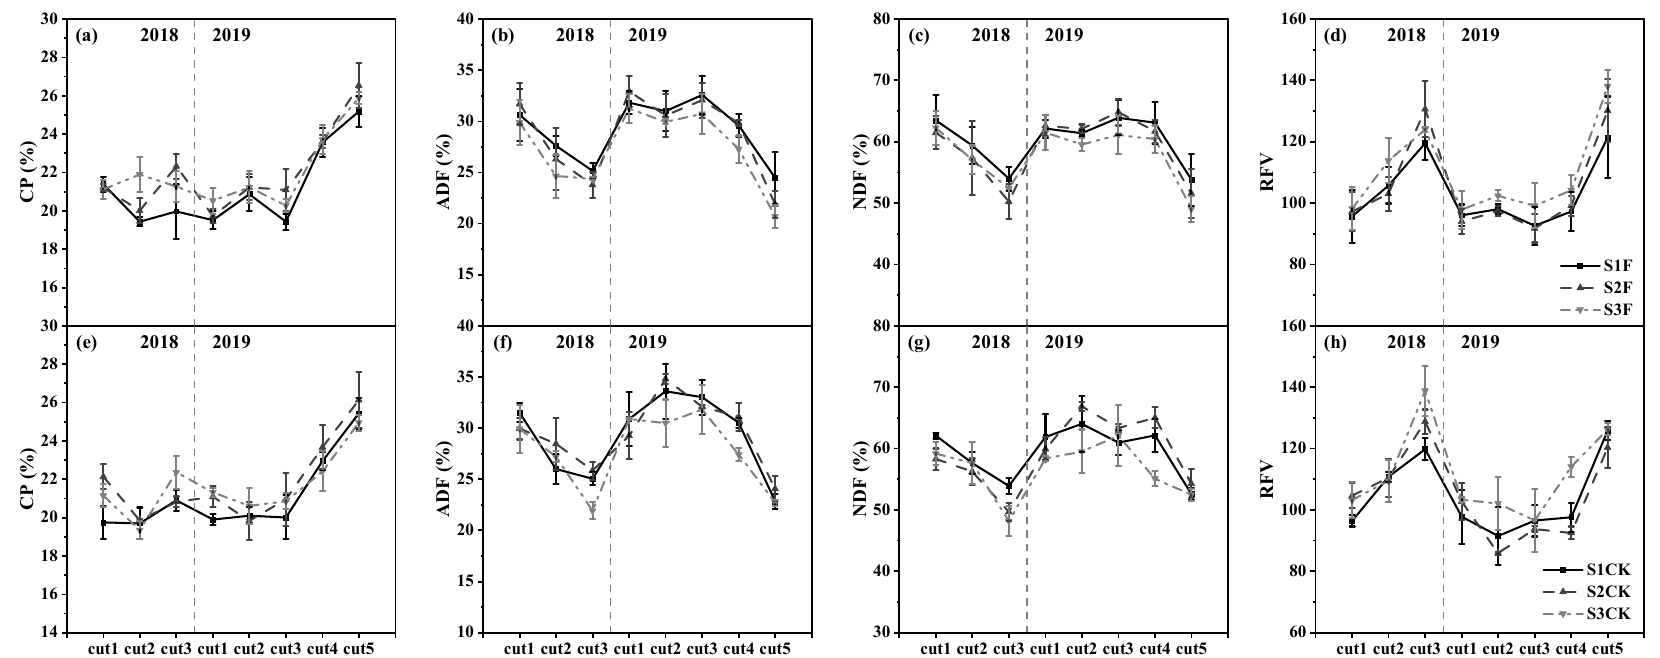
Figure 5. The change in alfalfa quality characteristics for each cut under different treatments in 2018 and 2019 for CP ( a , e ), ADF ( b , f ), NDF ( c , g ), and RFV ( d , h ). CP: crud protein; ADF: acid detergent fiber; NDF: neutral detergent fiber; RFV: relative feeding value. S1F, S2F, and S3F indicate soil salt contents (wt/wt) 2‰, 4‰, and 6‰, respectively, with biosolids fertilizer; S1CK, S2CK, and S3CK indicate soil salt contents (wt/wt) 2‰, 4‰, and 6‰, respectively, with no biosolids fertilizer.